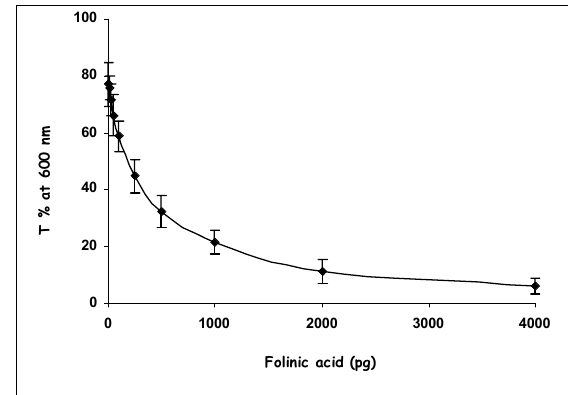
Figure 2. Standard curve based on the growth response of folinic acid to L. rhamnosus . Each value shown is the mean ± SD of 5 replicates of folinic acid containing standards (amounts of folinic acid were put into assay tubes of 3.9 ml).